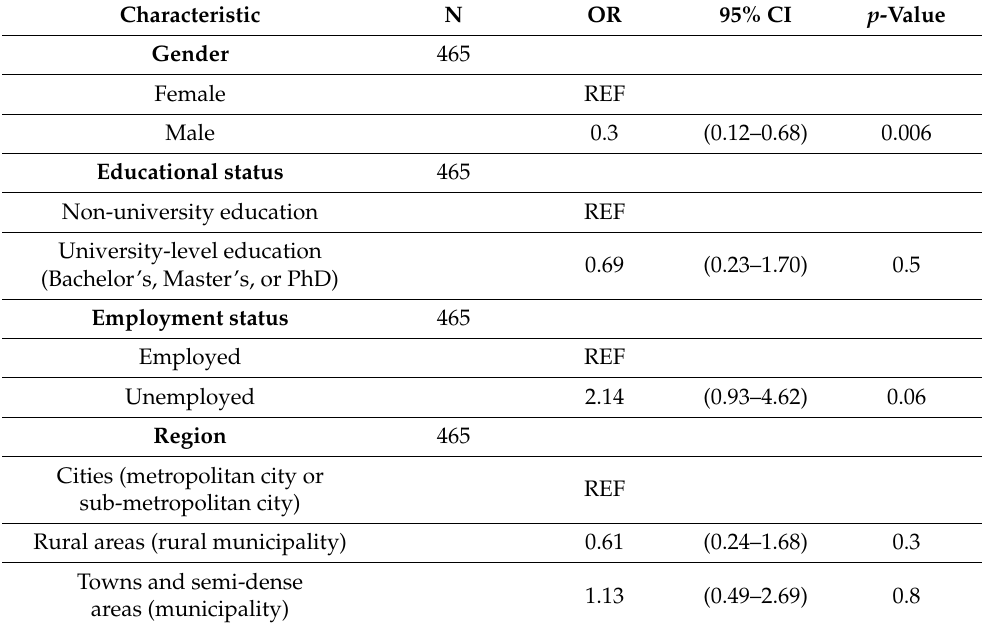
Table 3. Univariate logistic regression model of willingness to vaccination among unvaccinated